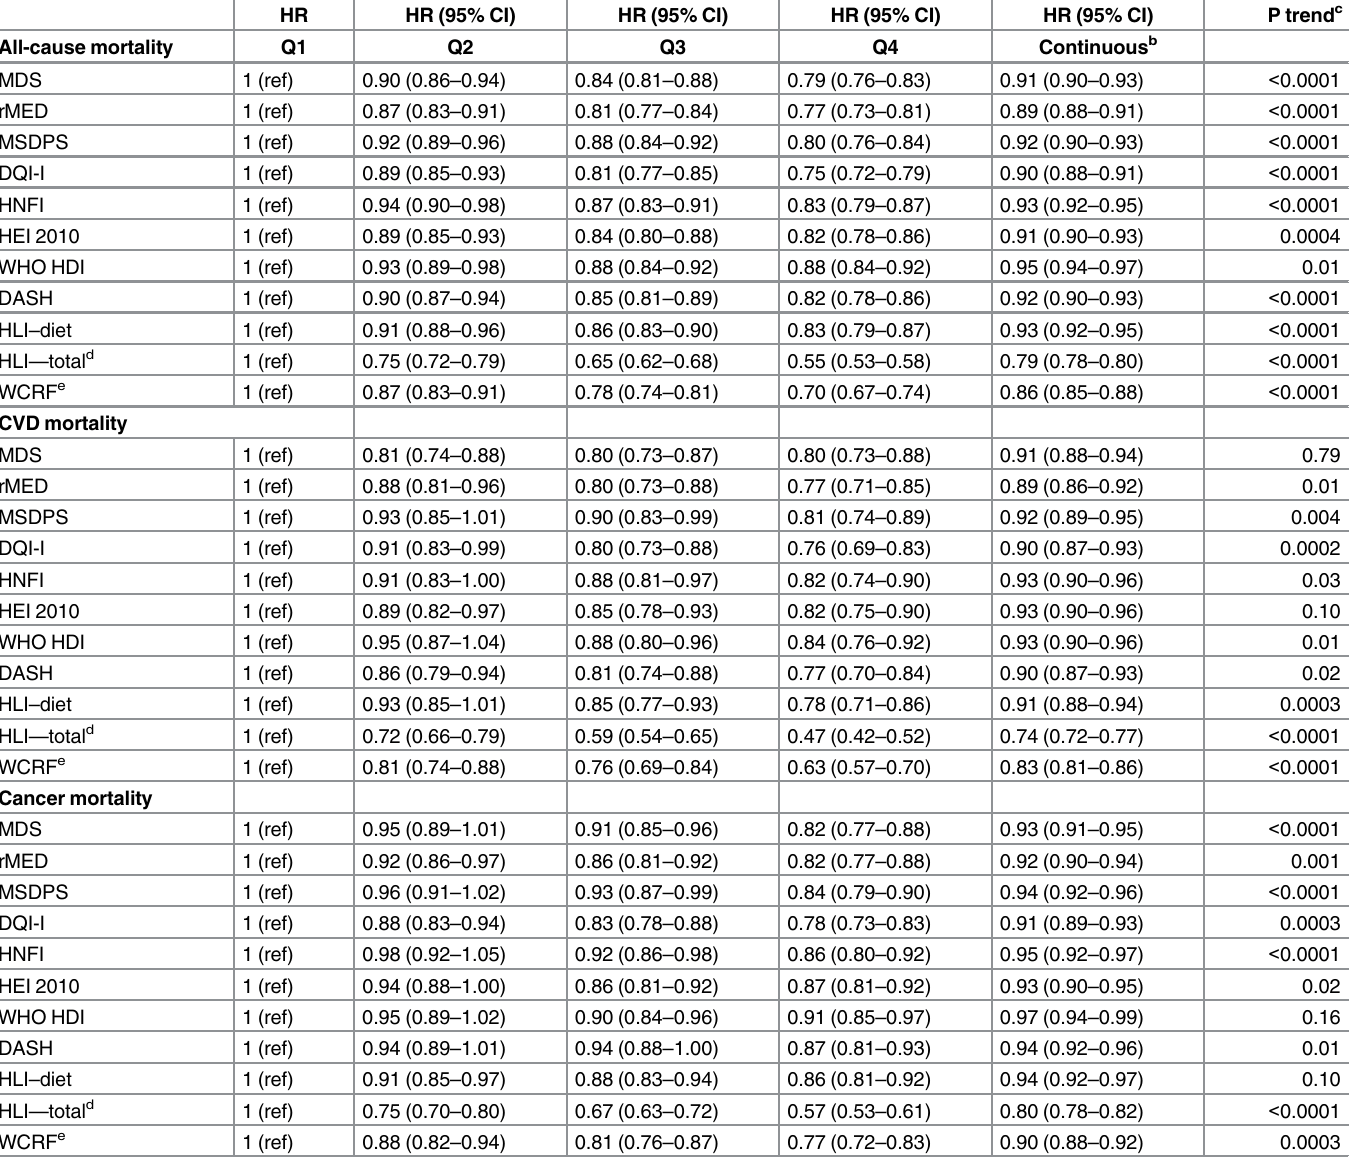
Table 4. Multivariate hazard ratios (Model 2) a for 10-year mortality risk by quartile of diet quality and for a 1SD increase of score among 451,256 participants of the EPIC